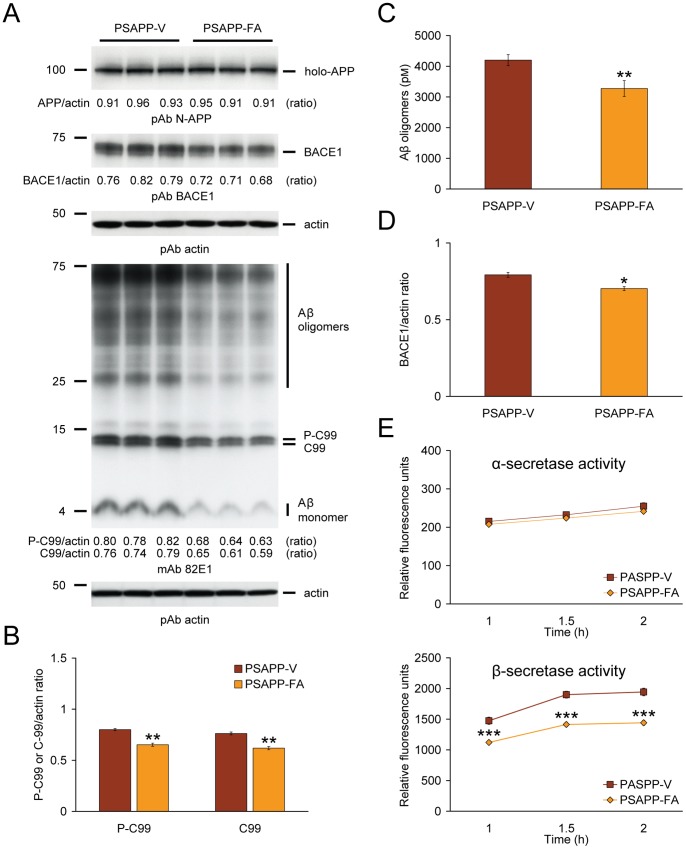
β-site amyloid precursor protein (APP) cleaving enzyme 1 (BACE1) modulation and inhibition of amyloidogenic APP processing in PSAPP mice treated with ferulic acid (FA).(A) Western blots are shown using an amino (N)-terminal APP polyclonal antibody (pAb N-APP; holo-APP is shown) and a carboxyl-terminal BACE1 polyclonal antibody (pAb BACE1). Western blots are also shown using an amino-terminal amyloid-β (Aβ) monoclonal antibody (mAb 82E1), which detects various amyloidogenic APP cleavage fragments including: Aβ monomer and oligomers as well as phospho-C99 (P-C99) and non-phospho-C99 (C99). Actin is shown as a loading control for each blot, and ratiometric densitometry data are shown below each lane. (B) Densitometry analyses are shown for ratios of C-99 or P-C99 to actin. (C) Aβ oligomers in the 2% SDS-soluble brain homogenate fraction were measured by sandwich ELISA. (D) Densitometry analysis is shown for ratio of BACE1 to actin. (E) α- and β-secretase activity assays are shown. Relative fluorescence units are depicted on the y-axis, and reaction time is represented on the x-axis. Representative Western blots for A were obtained from PSAPP mice treated with vehicle (PSAPP-V, n = 3) or with FA (PSAPP-FA, n = 3). Data for B-E were obtained from PSAPP mice treated with vehicle (PSAPP-V, n = 12) or with FA (PSAPP-FA, n = 12) for 6 months beginning at 6 months of age. All statistical comparisons are between PSAPP-V and PSAPP-FA mice.